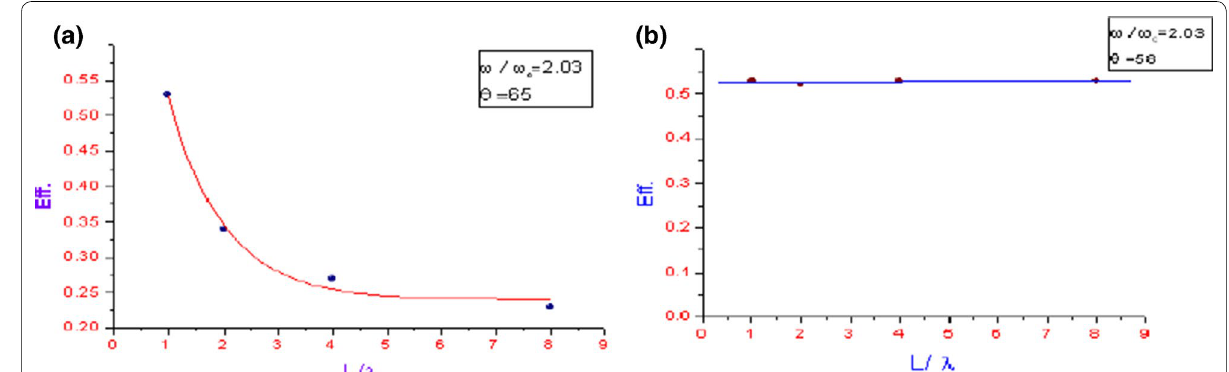
Fig. 2 Conversion efficiency as a function of the spatial scale of the density gradient in the case of ( a ) ω = 2.03 ω c with θ = 65 ◦ and ( b ) ω = 2.03 ω c with θ = 58 ◦ . The former case corresponds to the condition that two mode branches are disconnected (there is an evanescent zone between them), while in the latter case two mode branches are connected (Kalaee et al.